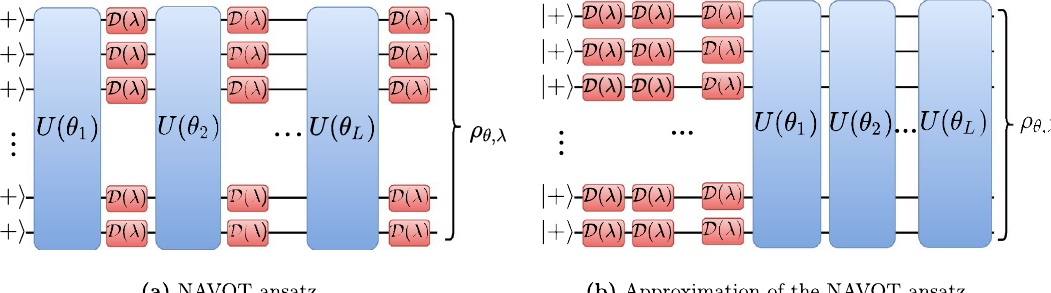
Figure 1. Illustration of circuit components used in NAVQT. ( a ) General NAVQT ansatz: a sequence of unitary layers U (θ i ) followed by depolarizing gates D ( (cid:31) ) on each qubit. ( b ) Approximation used in the free-energy